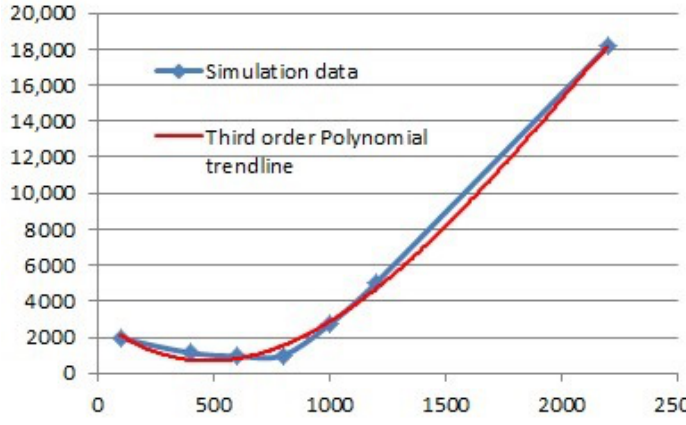
Figure 9. Speed of convergence for the